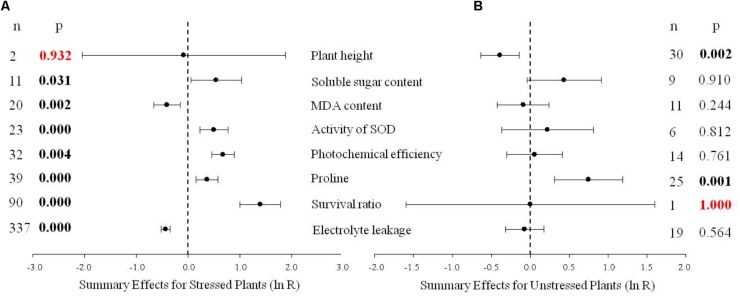
Weighted summary effect sizes (natural log of the transformed/control plant response ratios, ln R). Horizontal bars extending from the closed circle represent 95% confidence intervals (CIs). The dashed vertical line indicates effect size = 0. Summary effects were analyzed in plants exposed to temperature stress (A) and non-stress conditions (B). n, the number of studies in each summary effect. P ≤ 0.05 indicates a summary effect that is significantly different from zero (same for Figures 2–10).